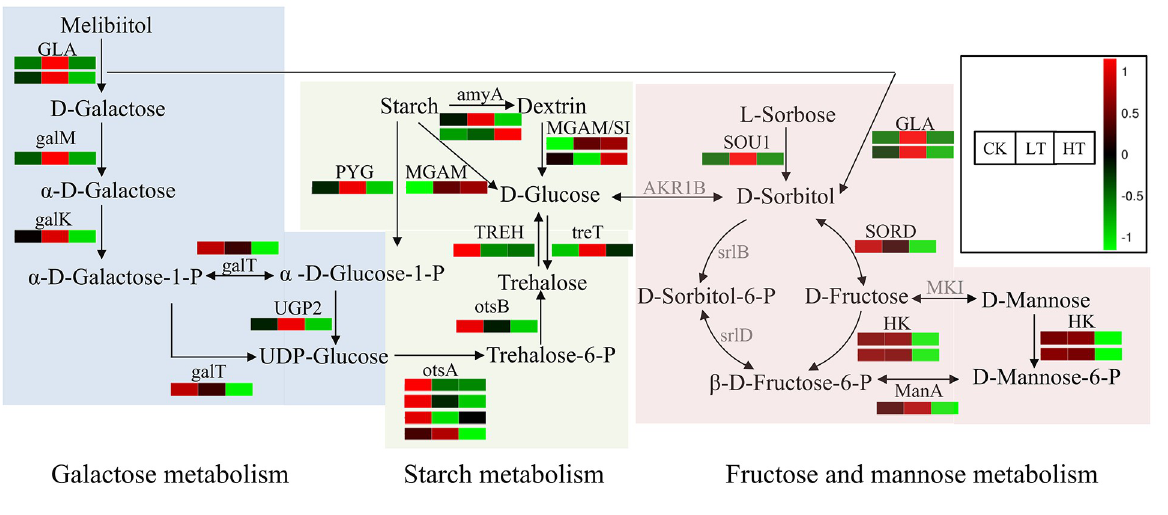
Fig 5. KEGG enrichment analysis of DEGs encoding key enzymes involved in the sugar metabolic pathways. Red and green indicate that the gene expressions were upregulated and downregulated, respectively. Grey indicates insignificant gene expressions. GLA, alpha-galactosidase. galM, aldose 1-epimerase. galK, galactokinase. galT, UDPglucose—hexose-1-phosphate uridylyltransferase. UGP2, UTP—glucose-1-phosphate uridylyltransferase. amyA, alpha-amylase. MGAM, maltase-glucoamylase. SI, sucrase-isomaltase. treT, trehalose synthase. otsA, trehalose 6-phosphate synthase. otsB, trehalose 6-phosphate phosphatase. TREH, alpha, alpha-trehalase. SOU1, sorbose reductase. SORD, L-iditol 2-dehydrogenase. HK, hexokinase. srlD, sorbitol-6-phosphate 2-dehydrogenase. srlB, glucitol/sorbitol PTS system EIIA component. MKI, mannose isomerase. ManA, mannose-6-phosphate isomerase. KEGG, Kyoto Encyclopedia of Genes and Genomes. DEGs, differentially expressed genes. LT, samples incubated at 22˚C. CK, samples incubated at 30˚C. HT, samples incubated at 42˚C.